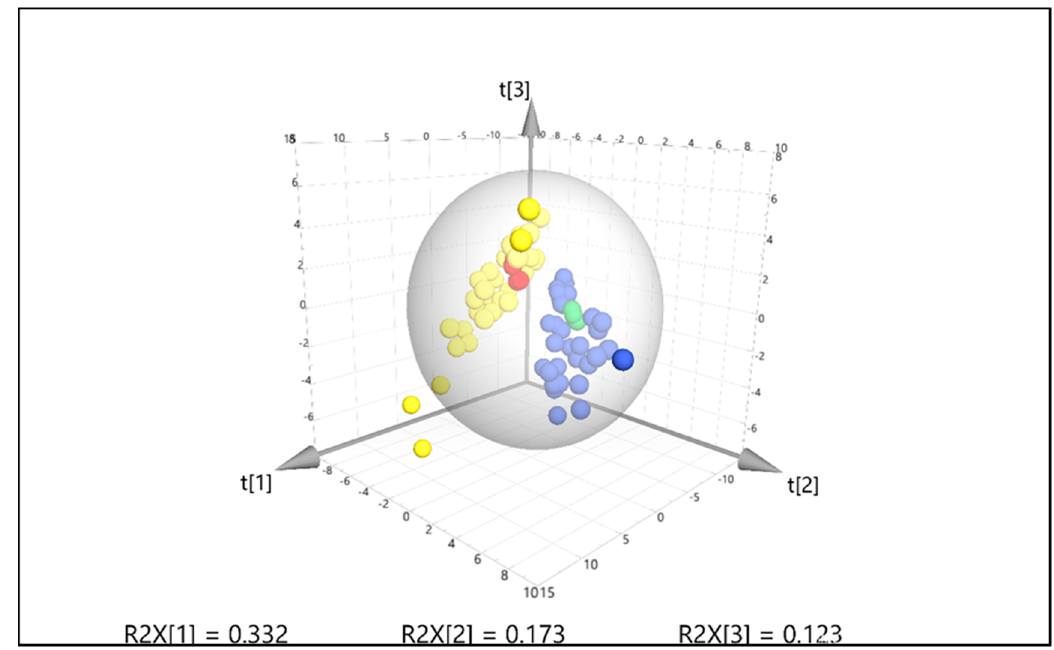
Figure 5. 3D-Score plot from PCA (unit variance scaled) of the profiles of 47 metabolites in all 36 mucus samples (without grouping according to sampling method) obtained from targeted LC–HRMS. The raw data were either processed using Thermo Fisher Xcalibur (samples in blue, Quality Control (QC) samples in green) or MZmine (samples in yellow, QC samples in red). The first three principal components explain 63% of the total variation.